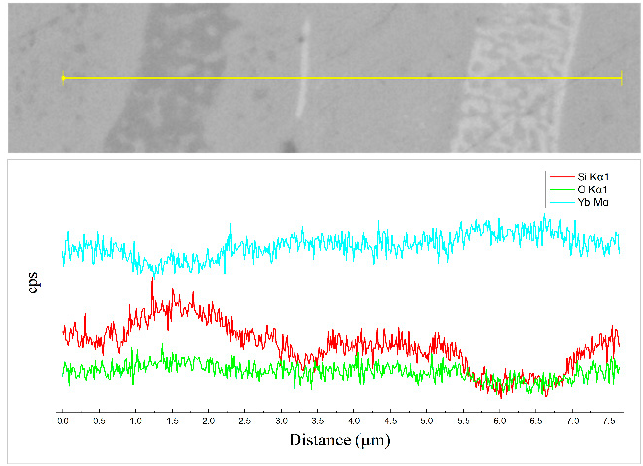
Figure 11. EDS line scan of the annealed ytterbium silicate top-coats prepared by parameter set